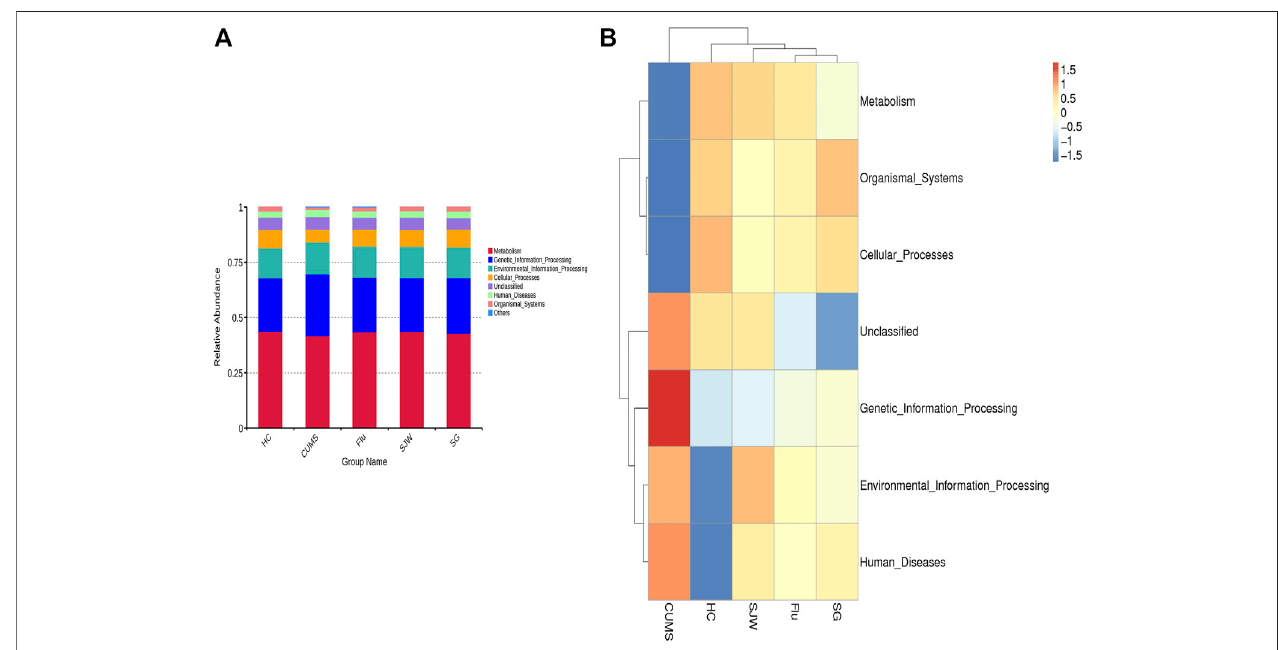
FIGURE 8 | (A) Histogram of functional annotation relative abundance between the fi ve groups on level 1. (B) Functional annotation clustering heat map using Tax4Fun on level 1.